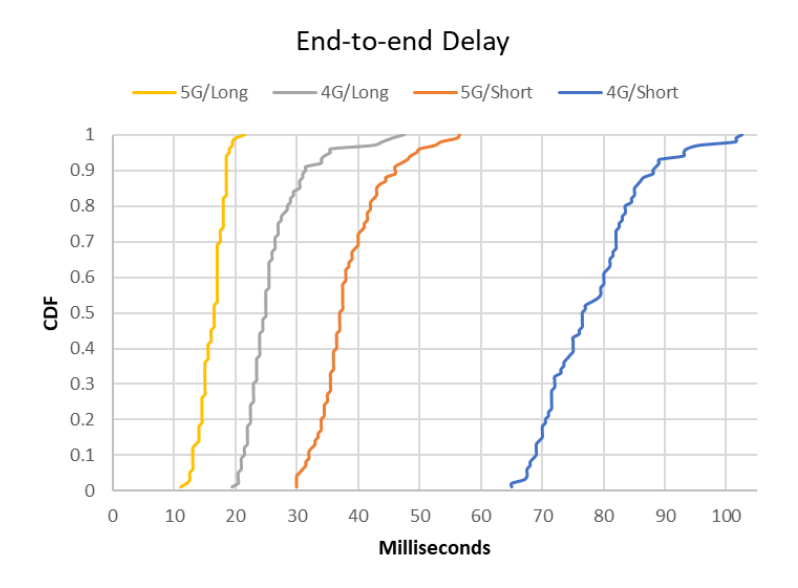
Figure 9. CDF of End-to-End Communication Delays.